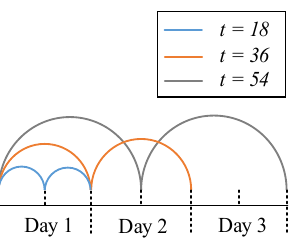
Figure 10. Five-fold cross-validation on t .